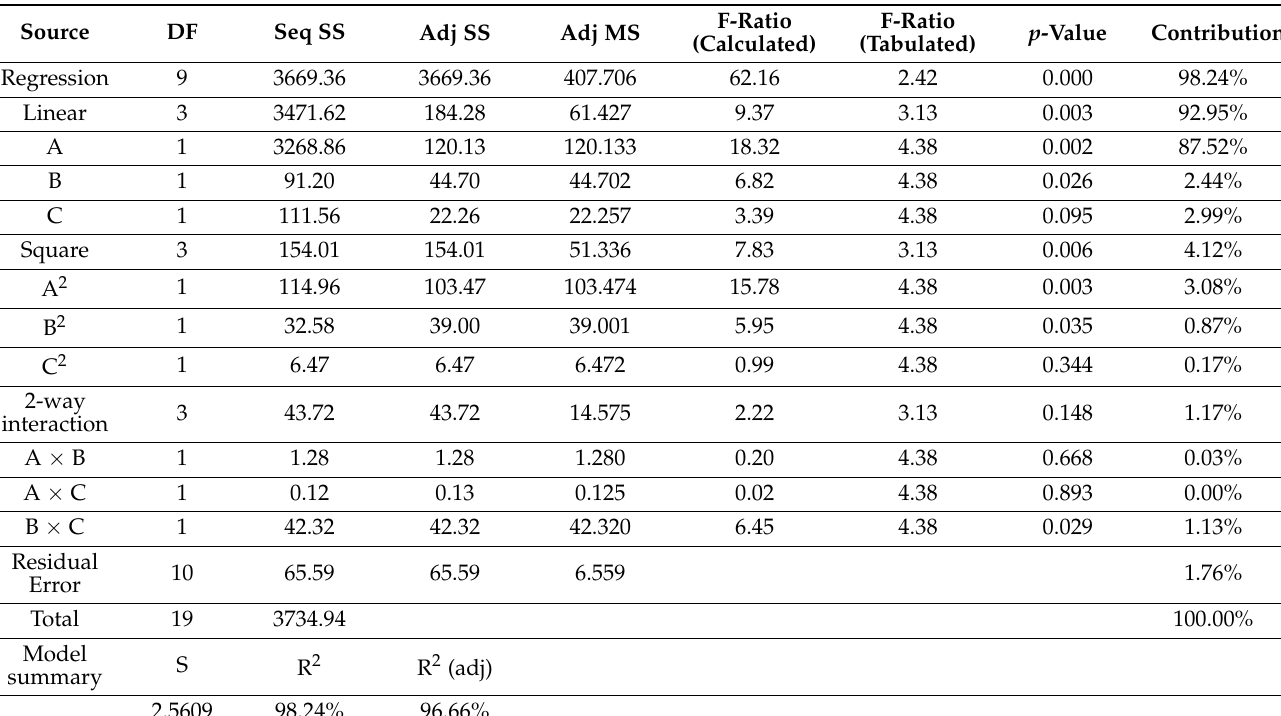
Table 7. ANOVA for drilling temperature of carbon fabric-neat epoxy.